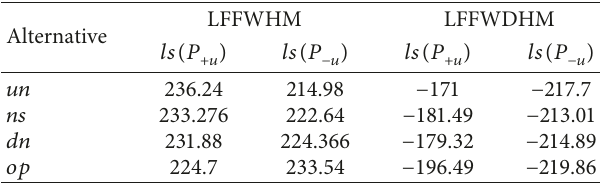
Table 7: Linguistic scores.